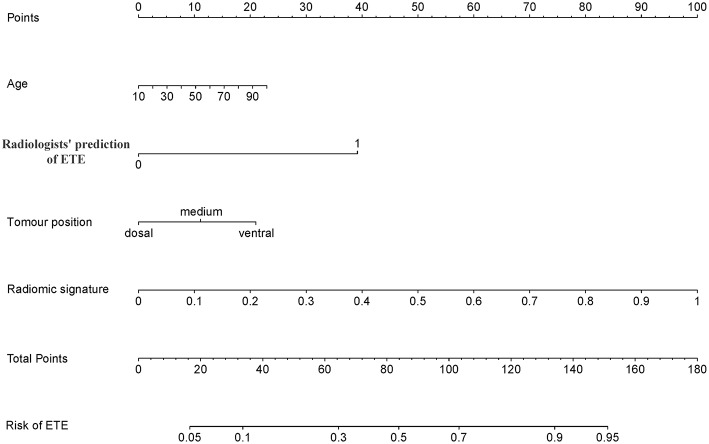
Radiomic nomogram. The radiomic nomogram incorporated age, radiologists' prediction of ETE, tumor position and the radiomic signature. For example, the primary tumor of a 50-year-old PTC patient was found on the ventral side of the thyroid and was determined to have ETE by CT; its radiomic signature score was 80, the total number of points of this tumor was 150 (10 + 40 + 20 + 80), and the risk rate of ETE was determined to be 95%. ETE, extrathyroidal extension; PTC, papillary thyroid carcinoma.